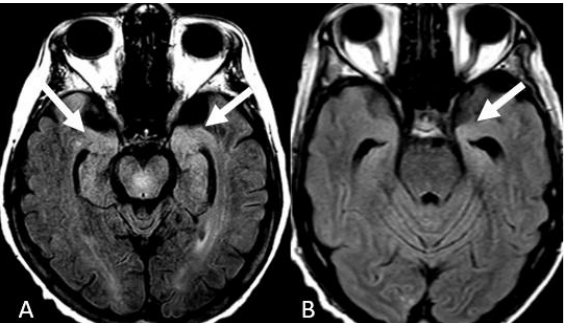
Figure 4. Temporal lobe involvement. ( A ) Axial FLAIR images depict bilateral medial temporal lobe FLAIR hyperintensities. ( B ) Isolated left medial temporal FLAIR hyperintensities. Image has been windowed manually to improve the visibility of signal abnormality.